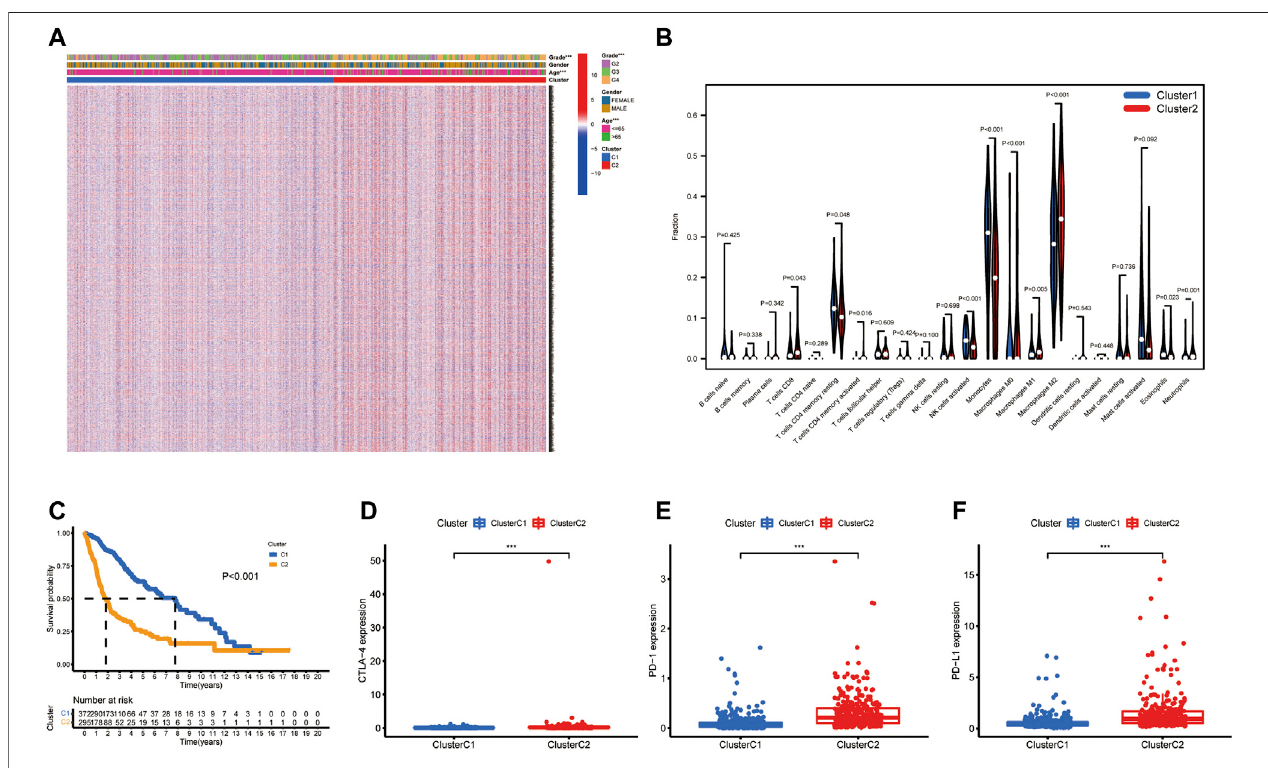
FIGURE2| TheclinicopathologicalandTMEcharacteristicsofthetwomolecularsubtypes. (A) Heatmapshowingclinicopathologicfeaturesofthetwoclusters. (B) The proportions of 22 immune cells among the clusters. (C) Kaplan – Meier curves for OS of the two clusters (log-rank tests, p < 0.001). (D – F) Histograms representing CTLA-4, PD-1, and PD-L1 expression. Data are shown as the mean ± SD; t test, * p < 0.05, ** p < 0.01 and *** p < 0.001 compared to the cluster C2 in (D – F)